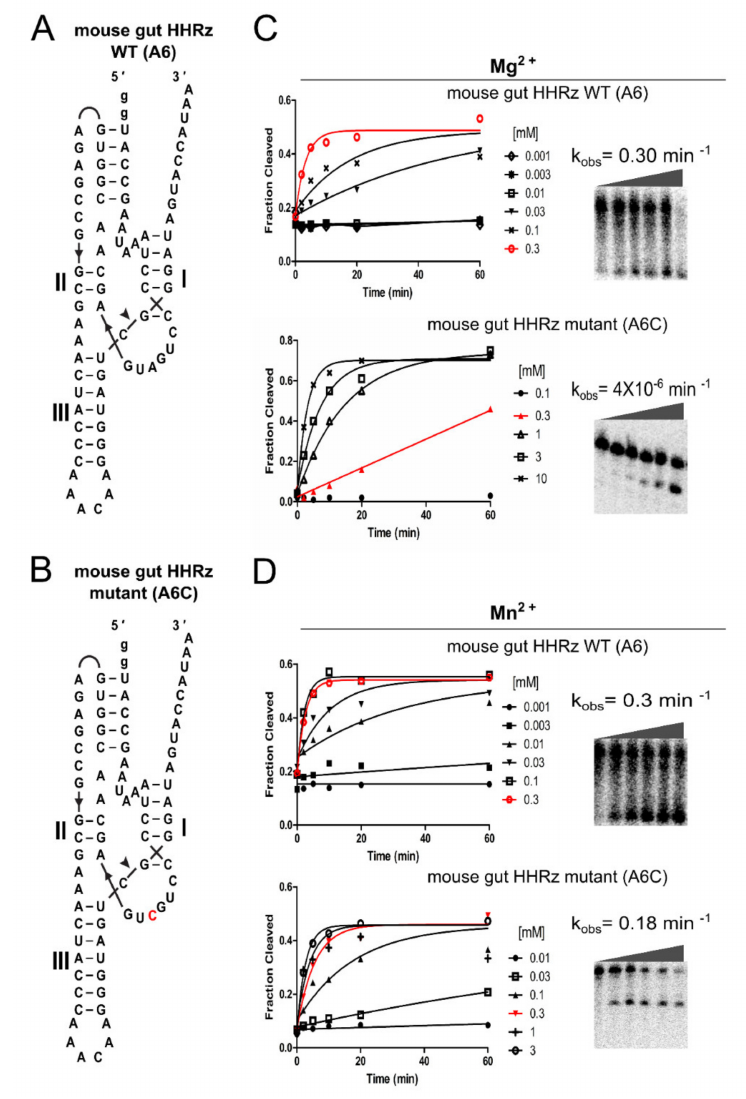
Figure 4. E ff ect of A6C mutation on self-cleavage activity for a pseudoknotted type II consensus core HHRz (A6) derived from the mouse gut metagenome (mouse gut HHRz). ( A , B ) Sequences and secondary structures of native mouse gut HHRz (A6) versus mutated mouse gut HHRz mutant (A6C), shown in red. ( C , D ) The gels are showing the self-cleavage activity of native mouse gut HHRz (A6) versus mutant HHRz (A6C) in the presence of 300 µ M of Mg 2 + or Mn 2 + . The graphs correspond to the fraction cleaved for all the concentrations indicated, red curves correspond to 300 µ M. The incubation times were 0, 2, 5, 10, 20 and 60